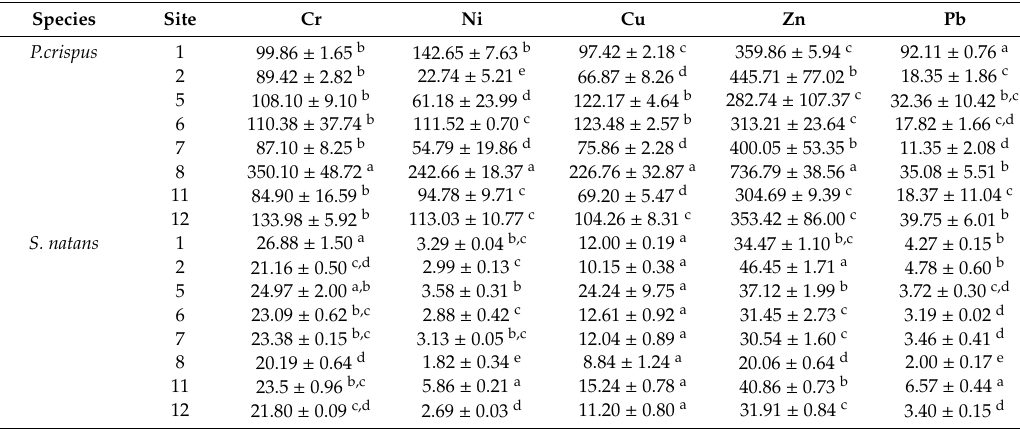
Table 6. Heavy metal levels of Potamogeton crispus and Salvinia natans . (mg / kg).